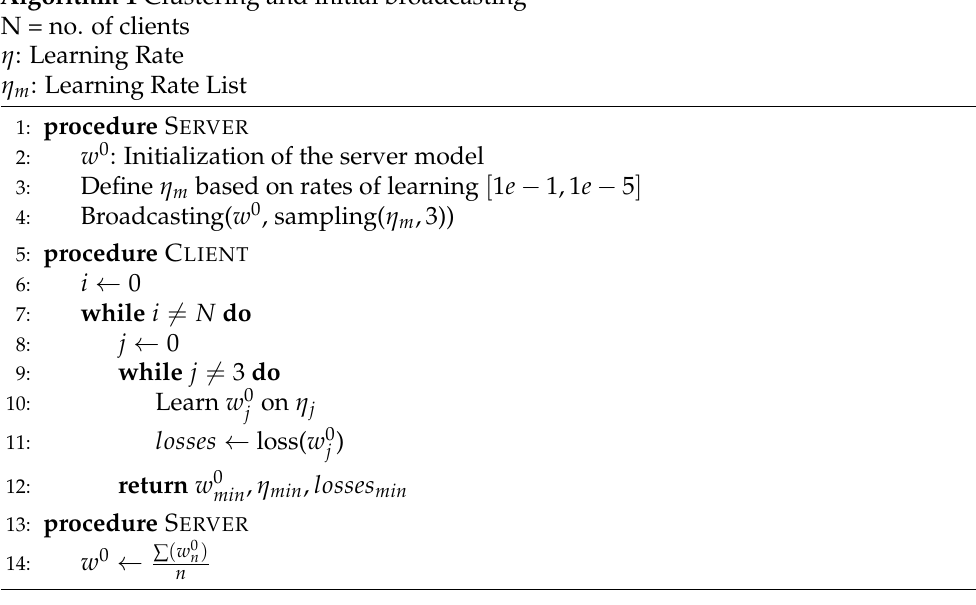
Algorithm 1 Clustering and initial broadcasting